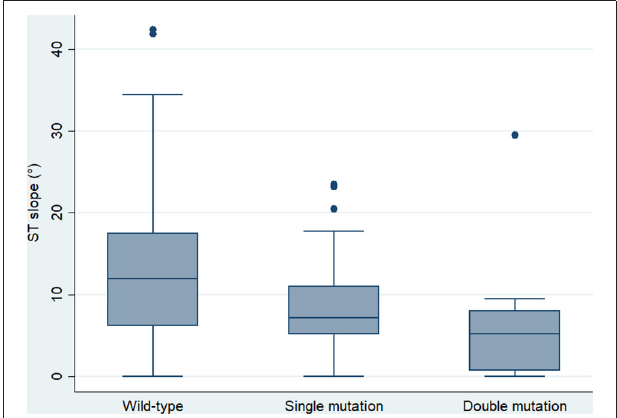
FIGURE 1 | Box plot showing the median and interquartile range of the ST slope in wild-type controls and single- and double-mutation carriers ( p =